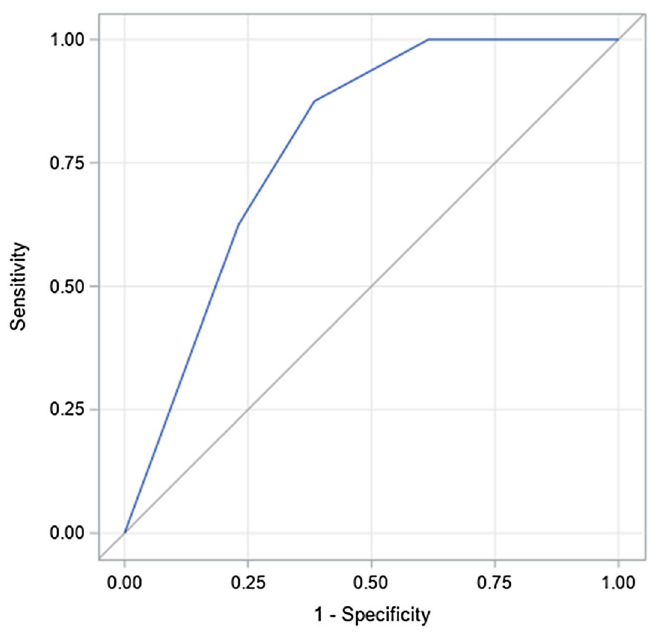
Figure 2. ROC curve for the duration from DNS diagnosis to the initiation of hyperbaric oxygen therapy for assessing the recovery in patients who received hyperbaric oxygen therapy. The area under the ROC curve is 0.789 (95% CI 0.603–0.974). The best cut-off point is at 3 days with a sensitivity of 0.875 and a specificity of 0.615. [SAS Enterprise Guide, version 7.1 (SAS Institute, Cary, NC,